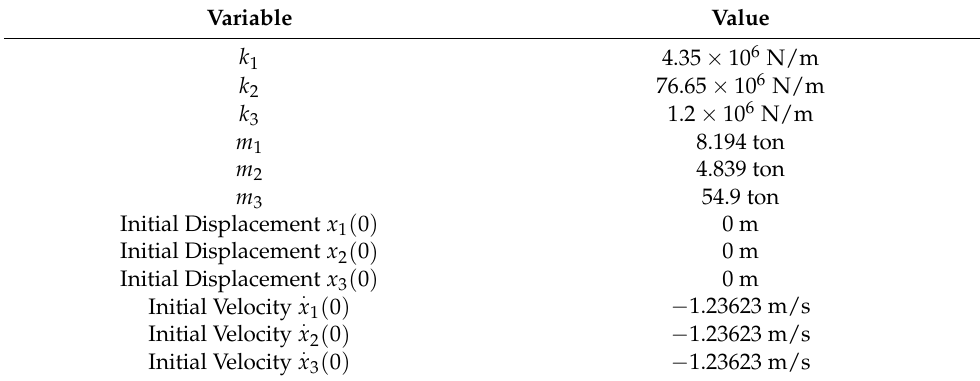
Table 5. Variable of